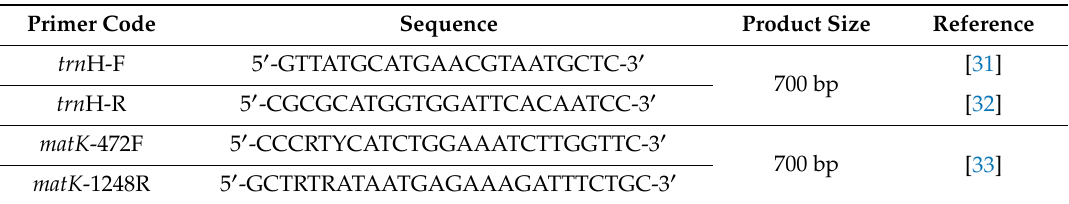
Table 3. Primer codes and sequences for barcoding the mat K and trn H